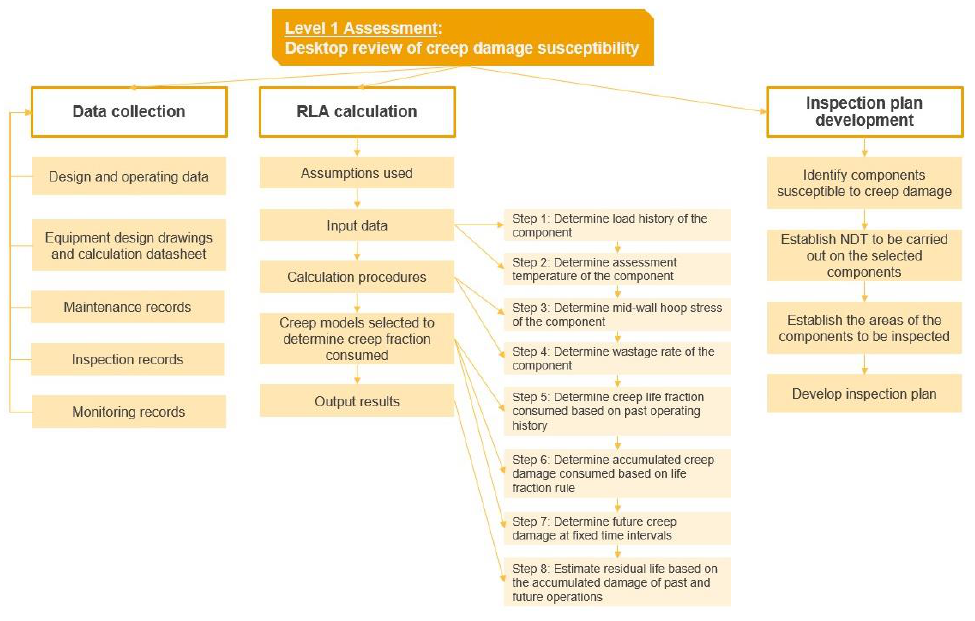
Figure 2. Flow chart on the steps for L1 approach in creep RLA.